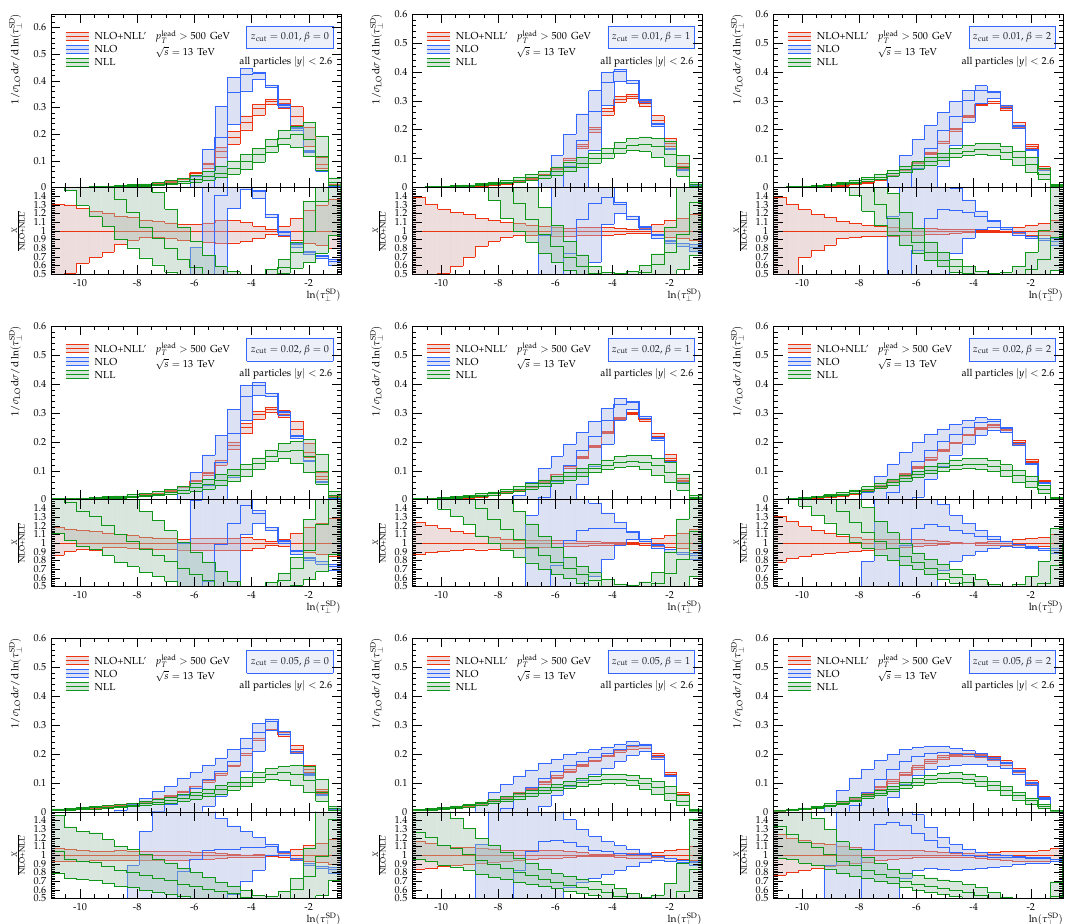
Figure 19 . NLL resummed predictions matched to LO and NLO for groomed transverse thrust for β ∈ { 0 , 1 , 2 } (columns) and z cut ∈ { 0 . 01 , 0 . 02 , 0 . 05 } (rows) for the p T, min = 500 GeV event selection, cf. figure 8 for